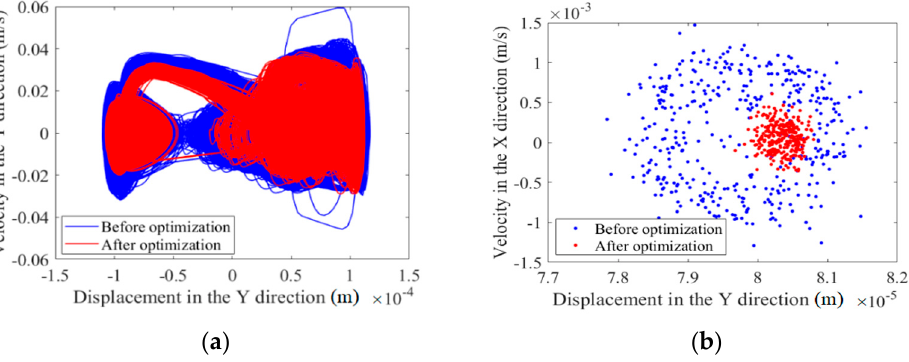
Figure 8. Nonlinear characteristics of joint A in the Y direction. ( a ) Phase map. ( b ) Poincaré map.